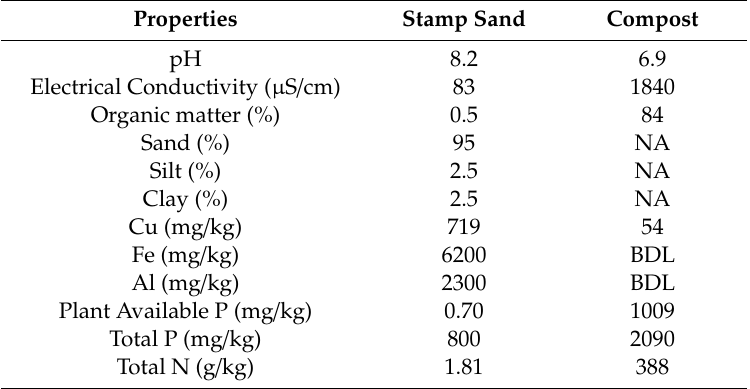
Table 1. Physicochemical properties of soil and